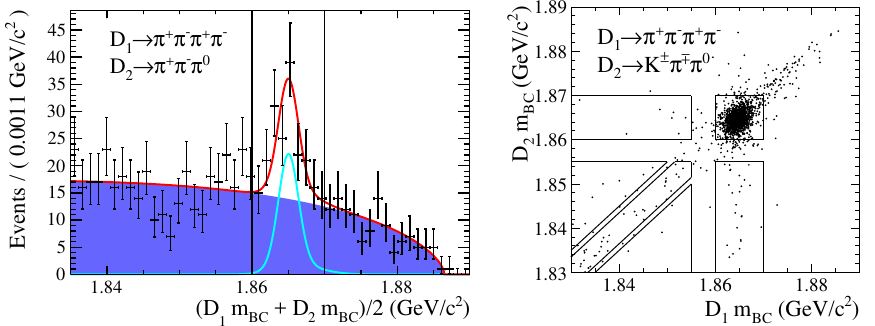
Figure 5 . (left) The m ave distribution of selected double-tagged (cid:25) + (cid:25) (cid:0) (cid:25) 0 candidates. Superimposed bc with a red line is the result of a unbinned maximum likelihood (cid:12)t described in the text. The shaded purple area shows the background PDF, and the blue line shows the signal PDF. The vertical lines show the signal region. (right) Two dimensional D 1 m bc vs. D 2 m bc distribution of selected double tagged K (cid:7) (cid:25) (cid:6) (cid:25) 0 candidates. The square box covering the range 1 : 86 (cid:0) 1 : 87 GeV shows the signal region, and the remaining boxes show the various sideband regions that are used to determine the combinatorial background